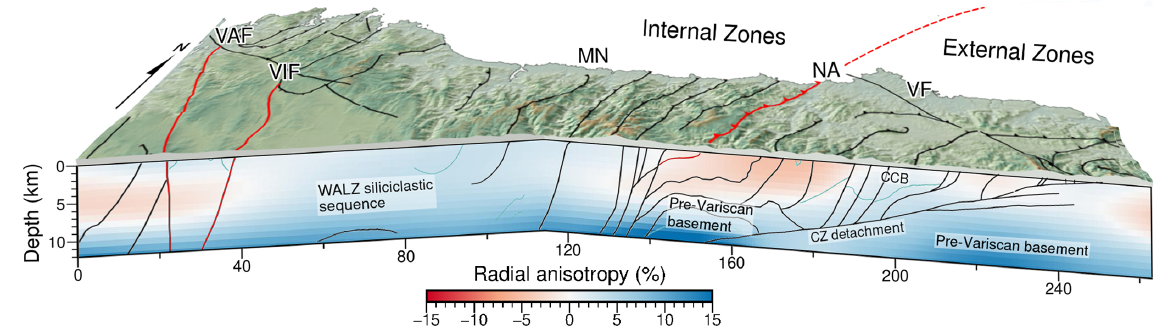
Figure 10. Schematic 3-D block showing the upper-crustal radial anisotropy variation across an E–W transect of the upper crust in NW Iberia. The main structural features are superimposed based on Pérez-Estaún et al. (1991). Red lines indicate the structures that bound the main Variscan domains displayed in Fig. 1. The location of the cross section is highlighted in Fig. 1a. CCB: Central Coal Basin, VF: Ventaniella fault, MN: Mondoñedo nappe, VIF: Vivero fault, VAF: Valdoviño